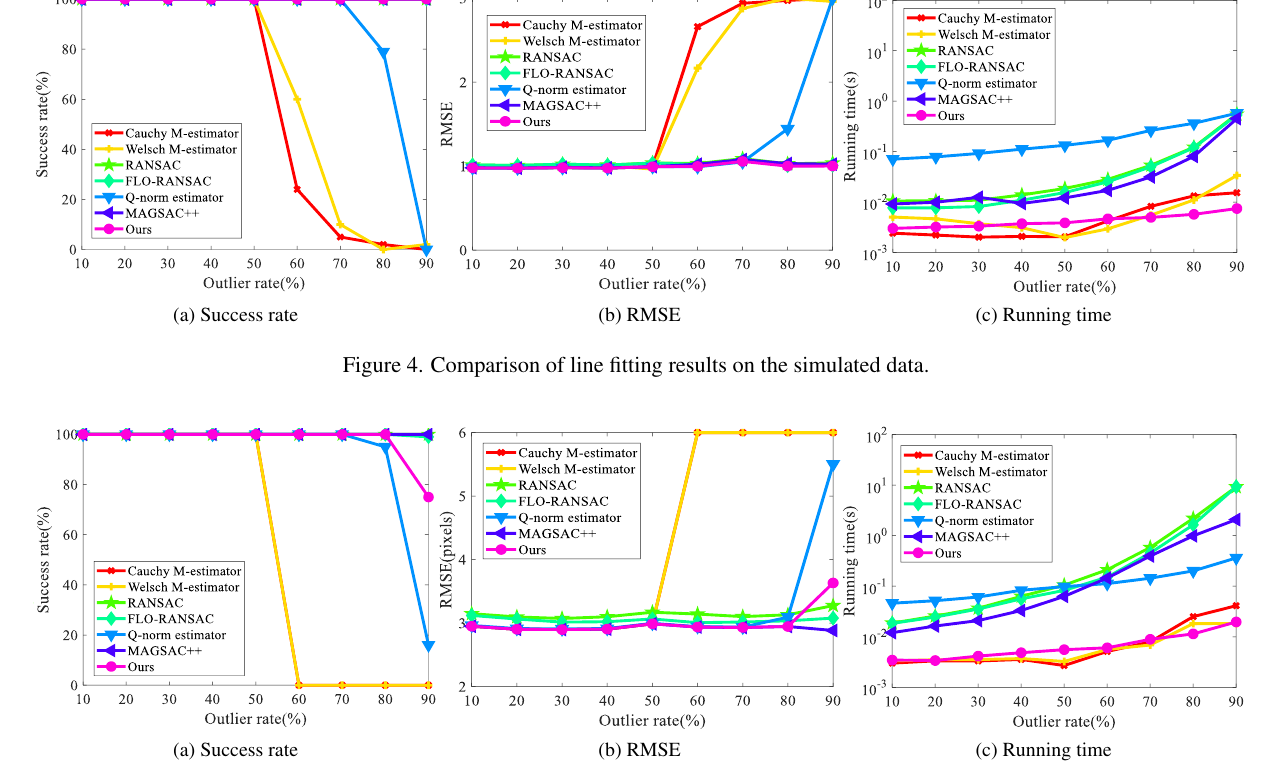
Figure 5. Comparison of feature matching results on the simulated